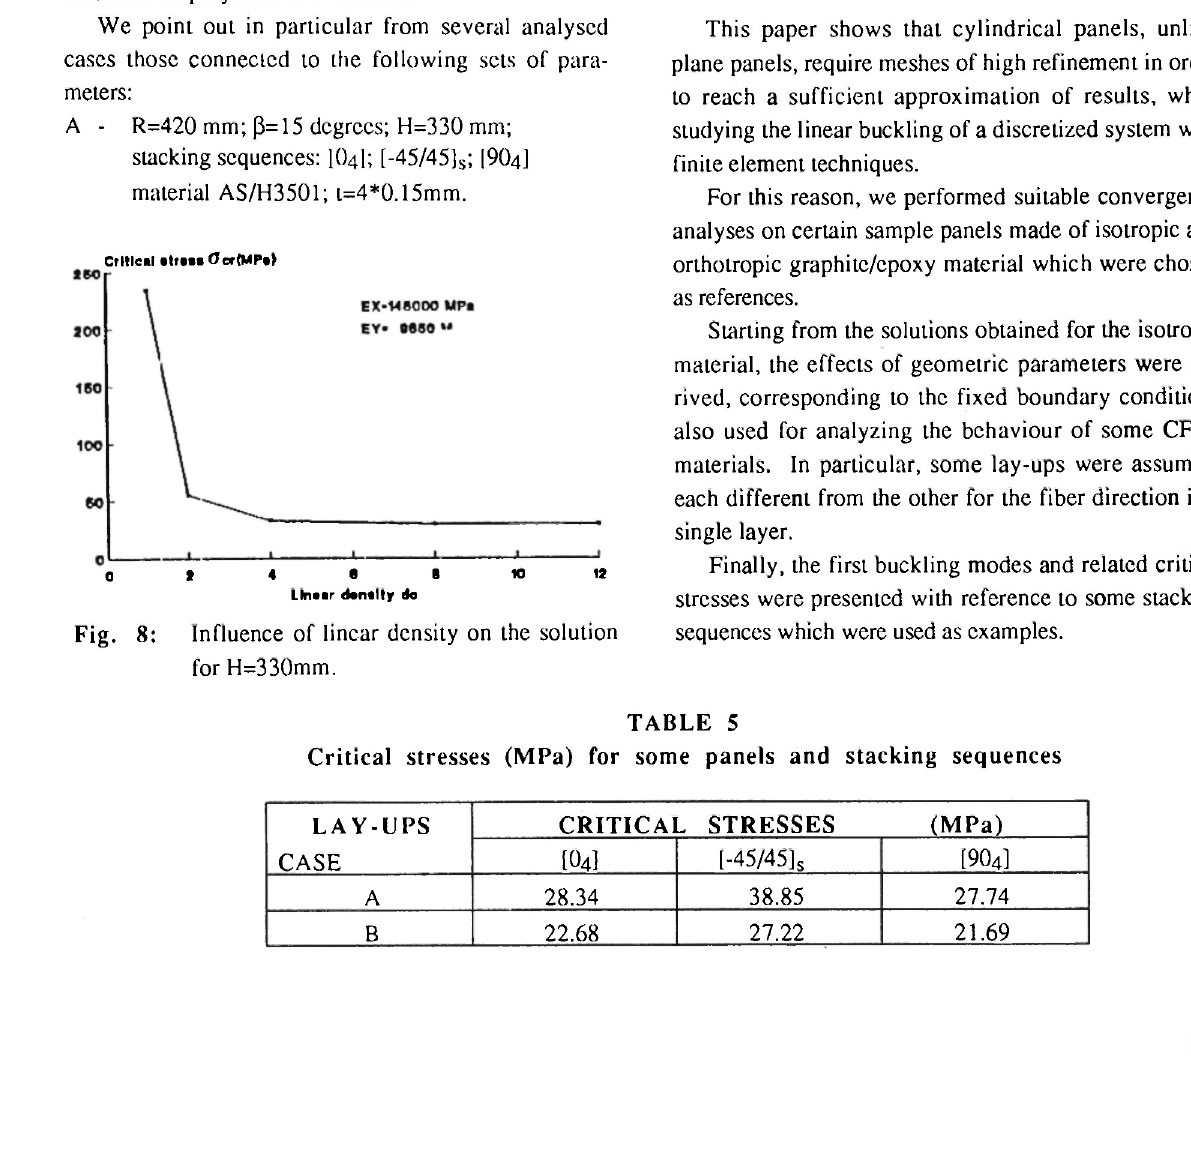
Critical stresses (MPa) for some panels and stacking